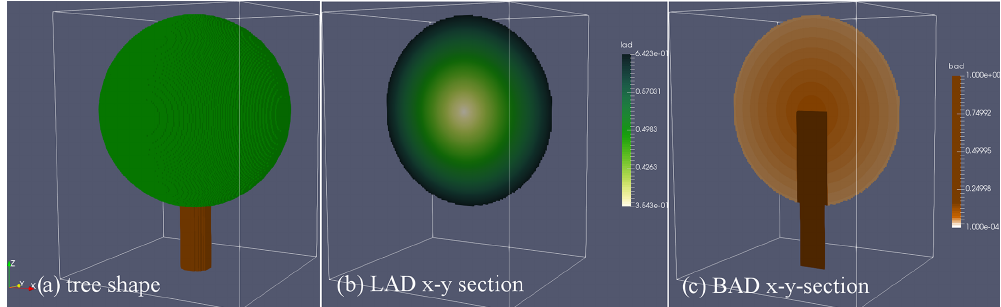
Figure 15. Exemplary distribution of LAD and BAD fields for a spherically shaped tree. Shown are (a) the three-dimensional tree surface and x – y sections of (b) LAD and (c) BAD through the centre of the